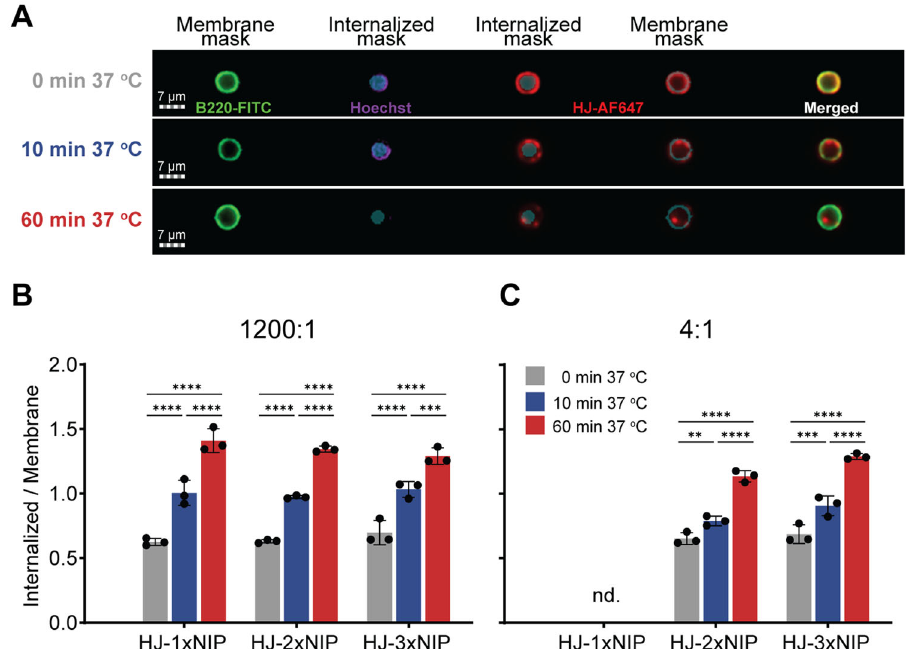
Fig.5|UptakeandinternalizationofHJsbyB1-8hiBcellsmeasuredbyimaging fl owcytometry.A Representativeimagesfromimaging fl owcytometryanalysesof uptake and internalization of HJs by B1-8hi B cells. A masking method was used to measure the amount of HJ signal (red) on the surface of the cells and within the cells. Membrane and internalization masks were made based on the B220 marker (green), either overlapping with it or excluding it. Nuclear Hoechst stain (blue) shows the potential overlap of internalized mask with the nucleus. B AF647 signal fromdifferentHJconstructswithinthesemaskswasquanti fi edacross3,000-5,000 individual cells and the median ratio of internalized/membrane signal was plotted